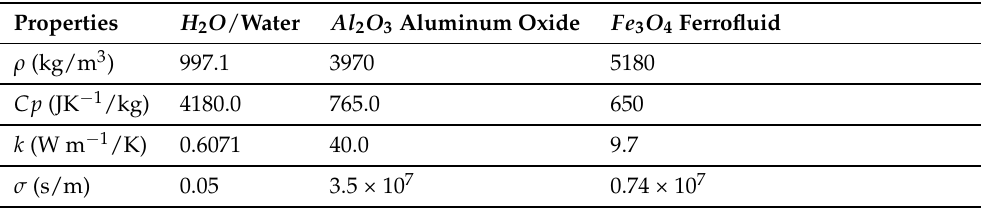
Table 1. Thermo-physical aspects of different fluids and nano-fluids.